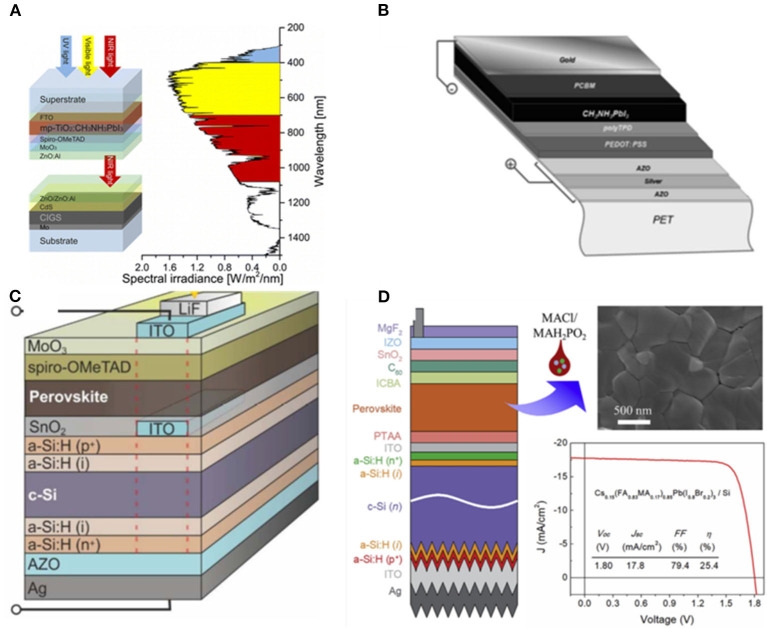
(A) Characterization of NIR-transparent PVSK cells (reproduce from ref. 26, copyright 2015, ACS). (B) Schematic layout of the flexible PVSK solar cell and chemical structure of the materials used as the electron and hole blocking layer (reproduced from ref. 27, copyright 2014, Royal Society of Chemistry). (C) Schematic device design of the Si heterojunction/PVSK tandem solar cell (reproduced from ref. 28, copyright 2016, Royal Society of Chemistry). (D) Schematic structure, J-V curves of Cs0.15(FA0.83MA0.17)0.85Pb(I0.7Br0.3)3/Si tandem device under forward and reverse scans with an inset photograph of the tandem device (reproduced from ref. 13, copyright 2017, Elsevier Inc.).